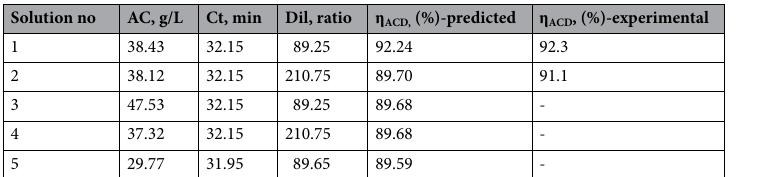
Table 3. The RSM optimization for active carbon decolorization of